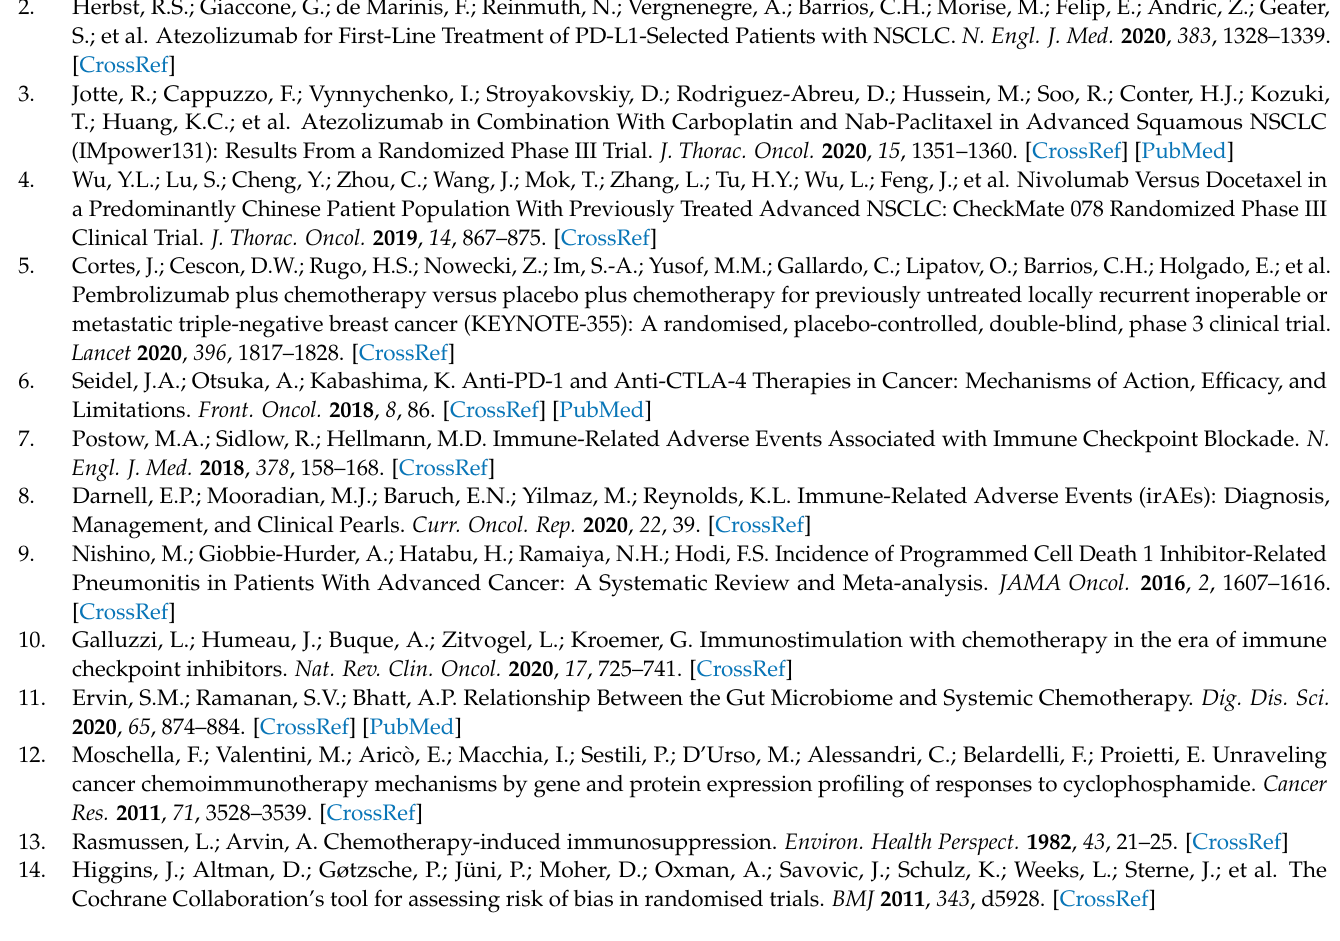
Figure S6: Publication bias for (A) any grade IRP and (B) grade 3–5 IRP in all